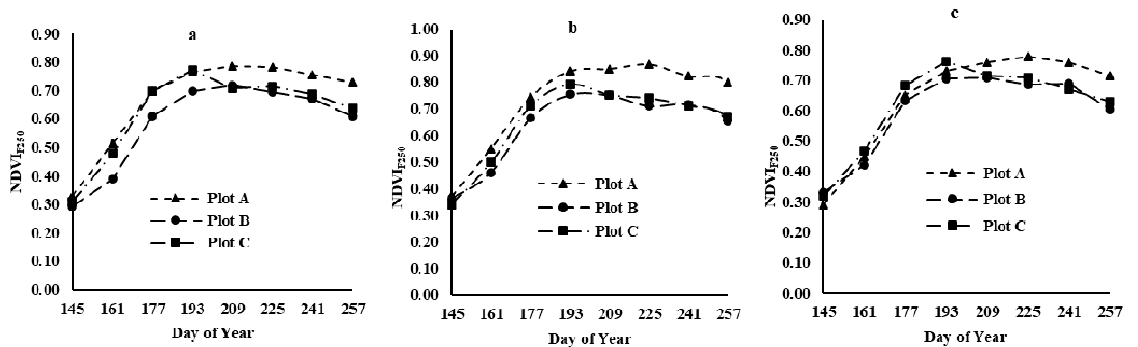
Figure 15. Time-series NDVI F250 fused with NDVI L30 of the three plots ( a ) fused with NDVI L30_174 ; ( b ) fused with NDVI L30_206 ; ( c ) fused with NDVI L30_254 ).